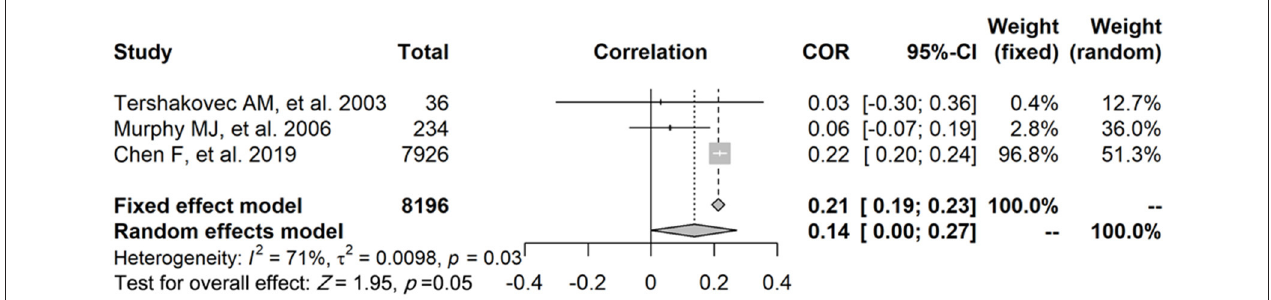
FIGURE 2 | The relationship between FFM and FPG, and three studies provided the correlation coefficient